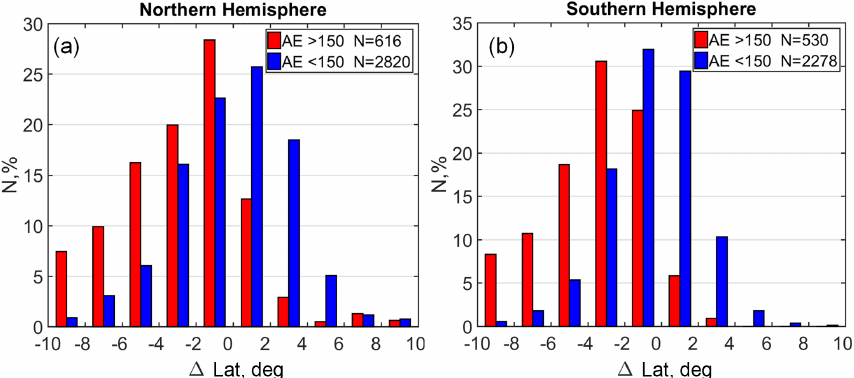
Figure 4. The distribution of (cid:49) Lat for AE > 150nT (red bins) and < 150nT (blue bins) for the Northern Hemisphere (a) and Southern Hemisphere (b) . N shows the number of events under the described